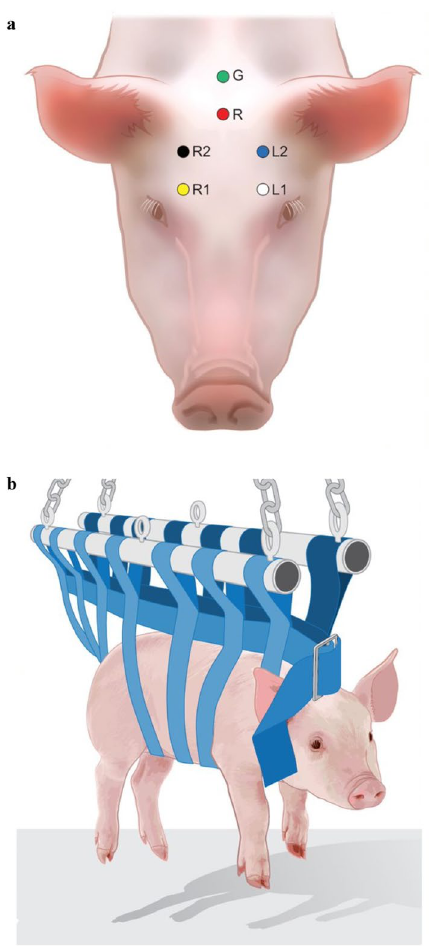
Figure 1. ( a ) Dorsal view of pig showing electrode placement in a six-channel montage (L1, L2, R1, R2, G = ground, R = reference). ( b ) Lateral view of the pig showing orientation of the sling for body support and connections used to suspend the pig within the container throughout the 15 min water-based foaming event. ( a ) and ( b ) were created using Adobe Illustrator v25.4.1 and Adobe Photoshop v22.5.4 (www. adobe.